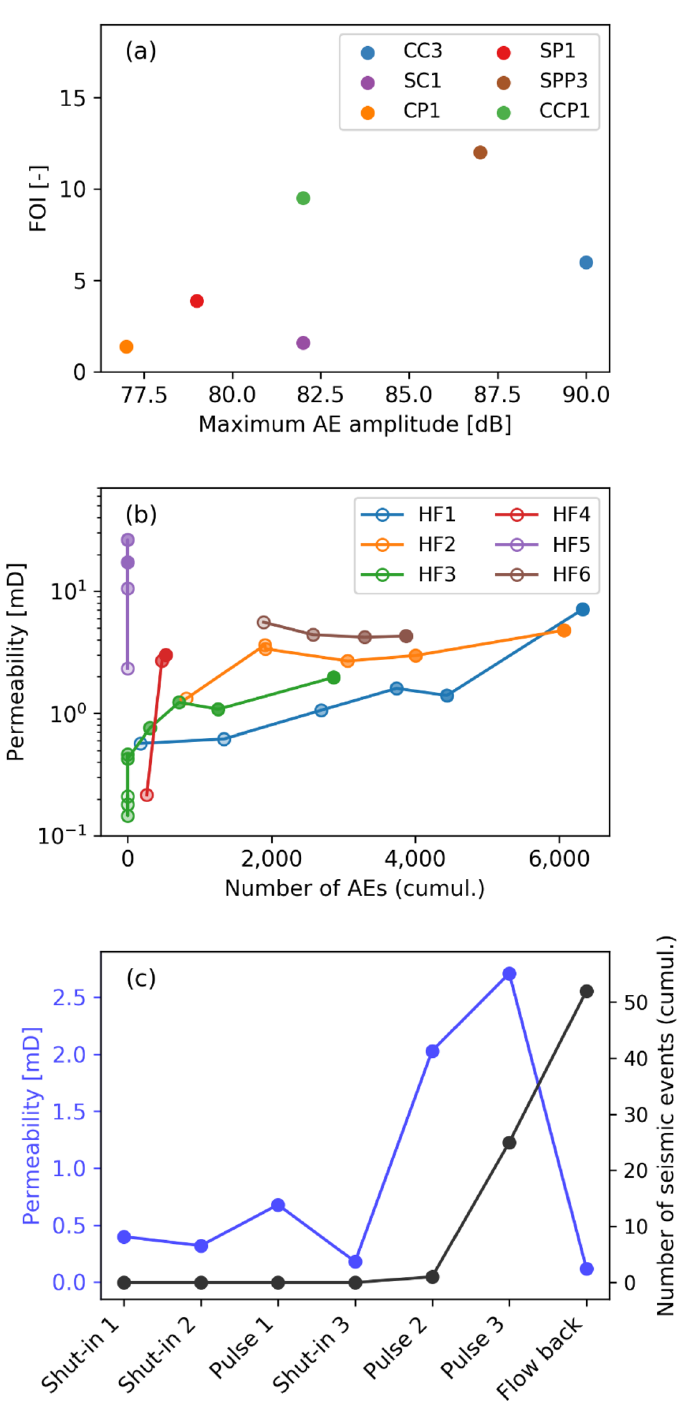
Figure 6. Permeability evolution across scale. ( a ) Fold of increase (FOI) of laboratory hydraulic fracturing test with different injection protocols: Flow-rate-controlled tests (CC3, SC1, CP1) and pressure-controlled tests (SP1, SPP3, CPP1). ( b ) Permeability enhancement for six field tests carried out in Äspö Hard Rock Laboratory: Conventional (HF1, HF2, HF4, HF6) and fatigue hydraulic tests (HF3, HF5). ( c ) Permeability development and seismicity observed during the field hydraulic test in the well PX1 in Pohang, South